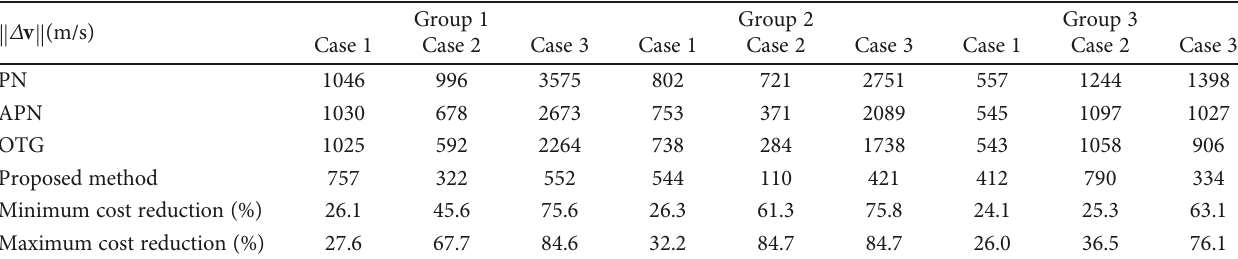
Table 5: Comparisons of simulation